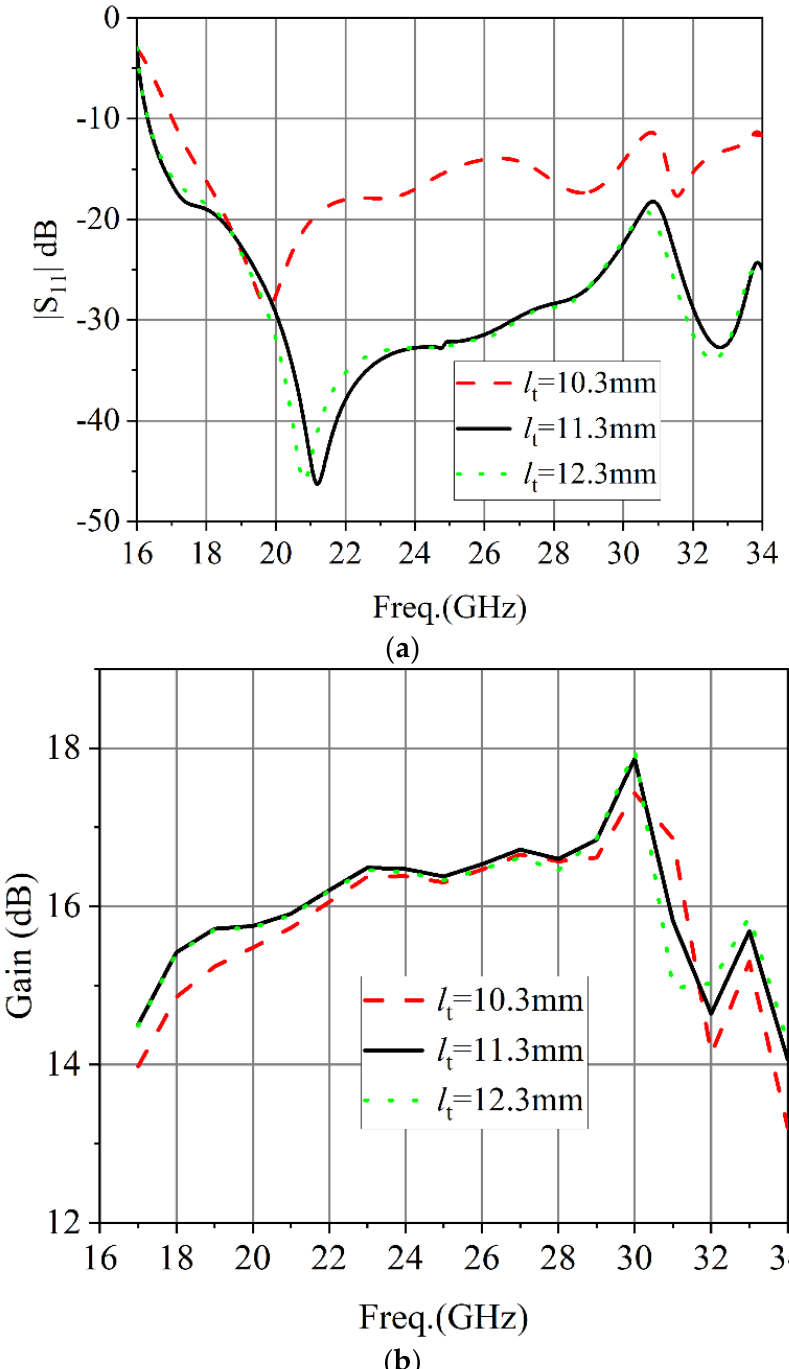
Figure 15. The simulated results of the length of the circular waveguide to horn antenna transition section: ( a ) |S 11 |. ( b ) Gain.